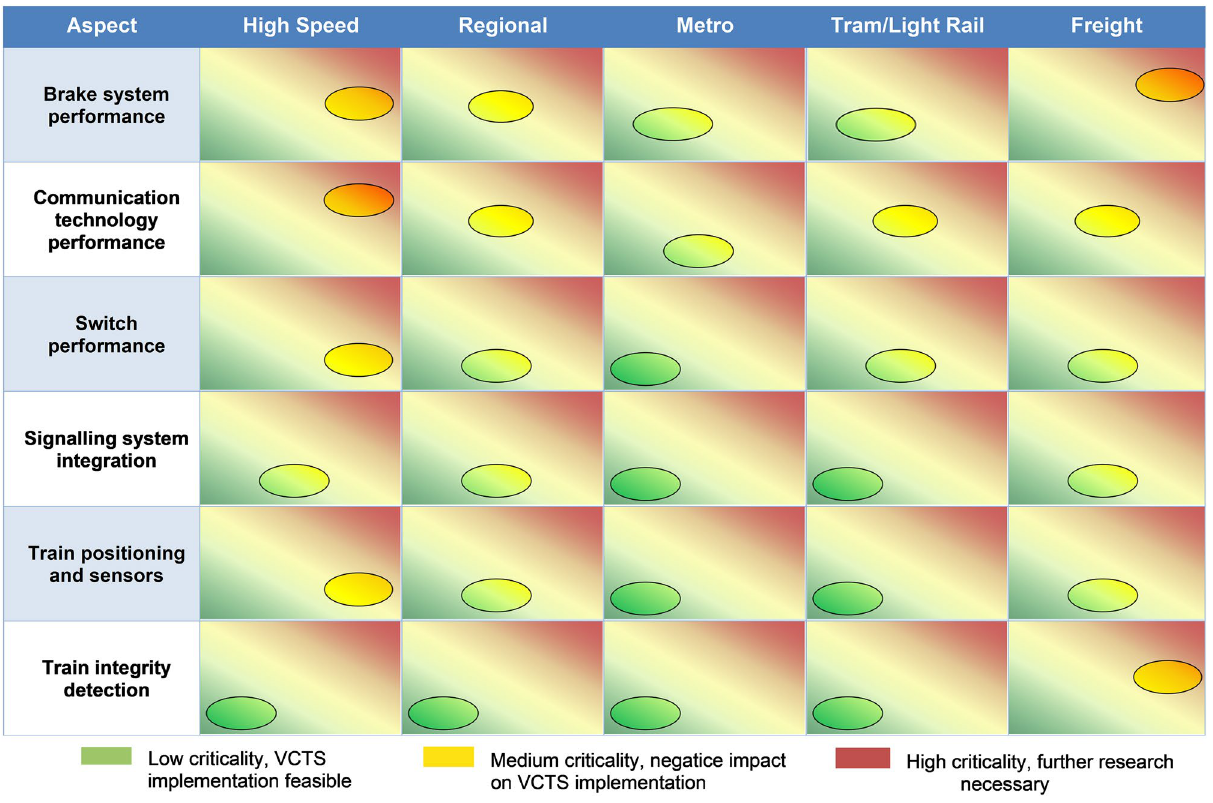
Figure 5. Qualitative VCTS criticality assessment of the most important identified aspects, based on expert interviews.